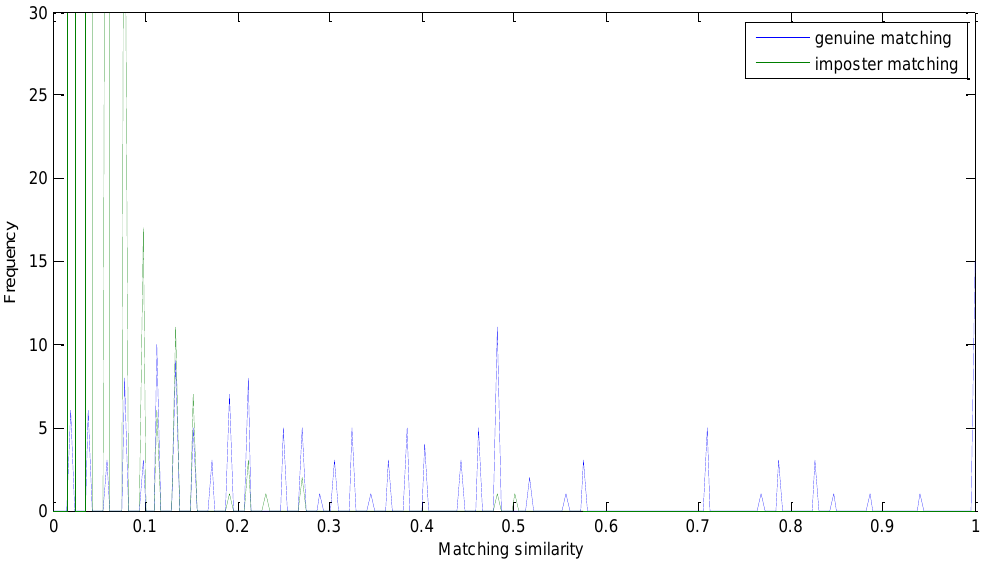
Figure 9. Similarity distribution without